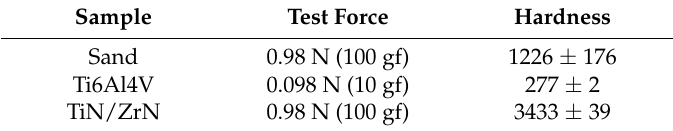
Table 2. Testing hardness results of sand particle, Ti6Al4V, and TiN/ZrN.